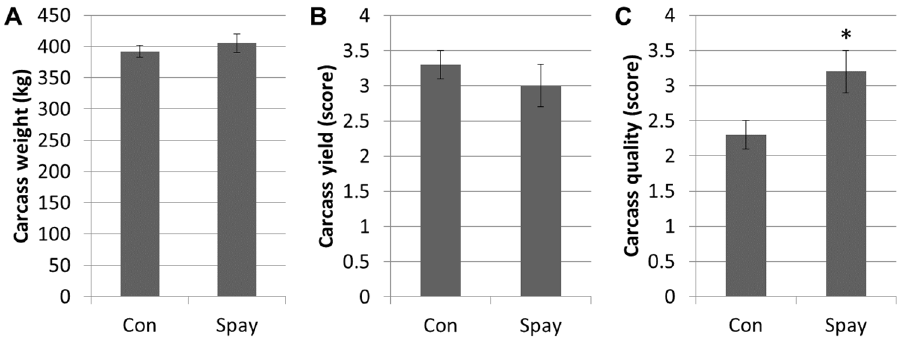
Figure 3. Records for carcass after slaughtering. ( A , B ) Both carcass weight and yield are not signif- icantly different between groups. ( C ) Carcass quality (marbling degree) is significantly ( p < 0.05) greater in the spayed heifers than in controls. Significant difference ( p < 0.05) is indicated by an asterisk in the top of bar. Graphs are presented as mean ± SEM. Statistical analysis: Student’s t-test. Abbreviations: Con, unspayed control group; Spay, spayed group. Abbreviations: Con, unspayed control group; Spay, spayed